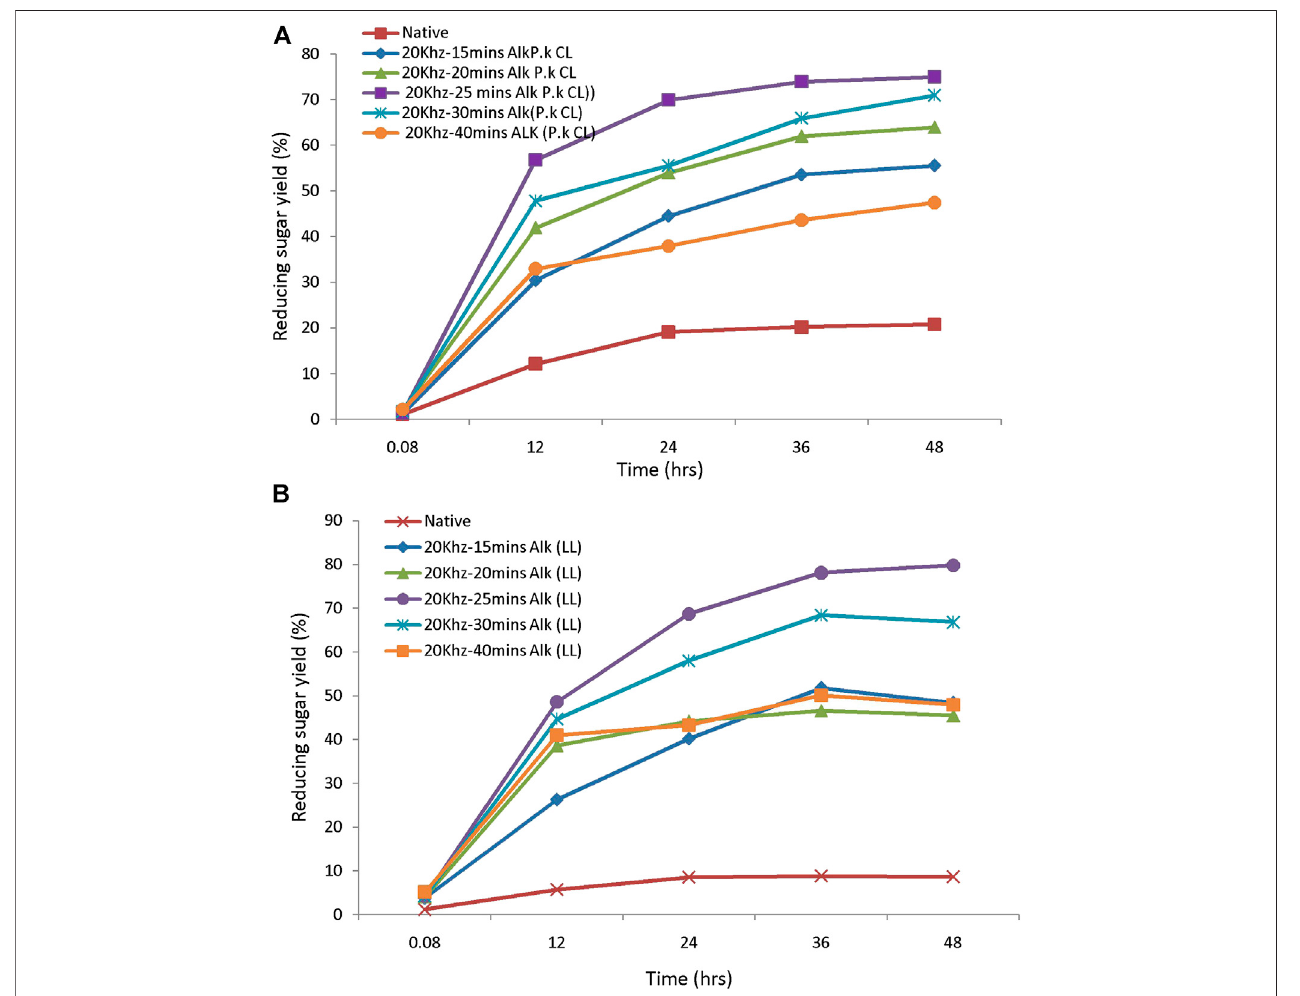
FIGURE 4 | The enzymatic hydrolysis ef fi ciency of sono-assisted alkali-pretreated tall reed biomass: (A) Chilika Lake and (B) Loktak Lake.